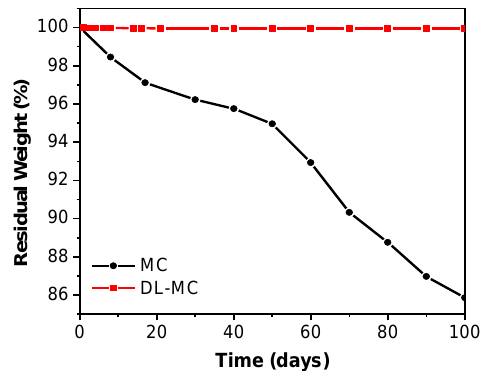
Figure 8. MCs and DL-MCs weight changes under ambient conditions. ◦ In the TGA results, DL‑MC exhibited a minor loss up to about 100 C and sequential ◦ sharp losses ranging from 100 to 150 C. This means that the core substance (MNFB)